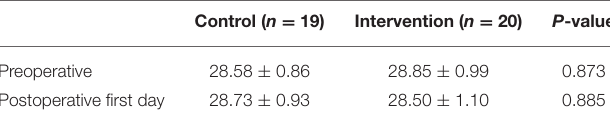
TABLE 5 | Comparison of preoperative and postoperative MMSE